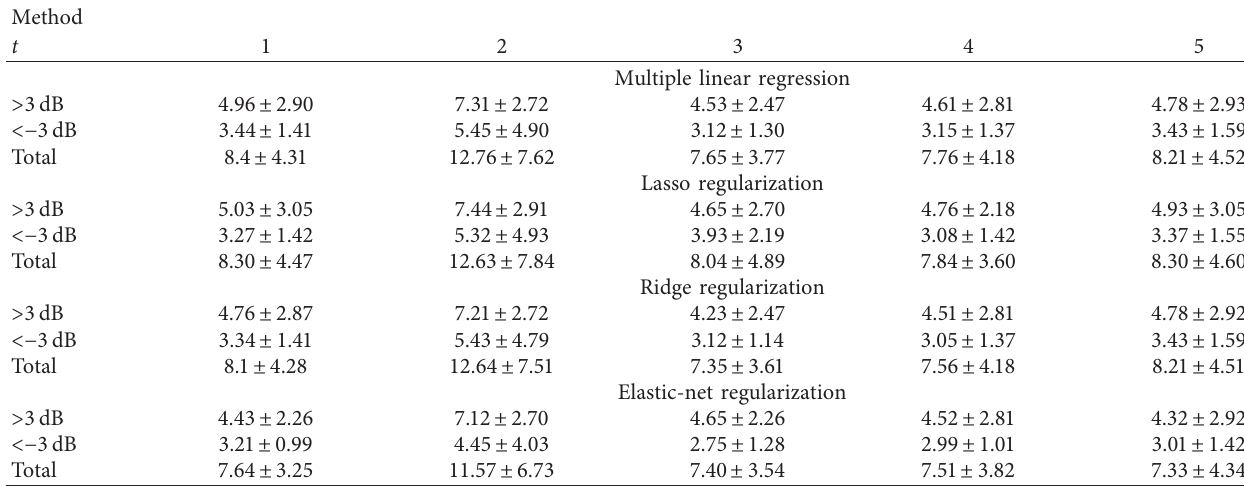
Table 4: 3 dB error results based on vibration response prediction model.